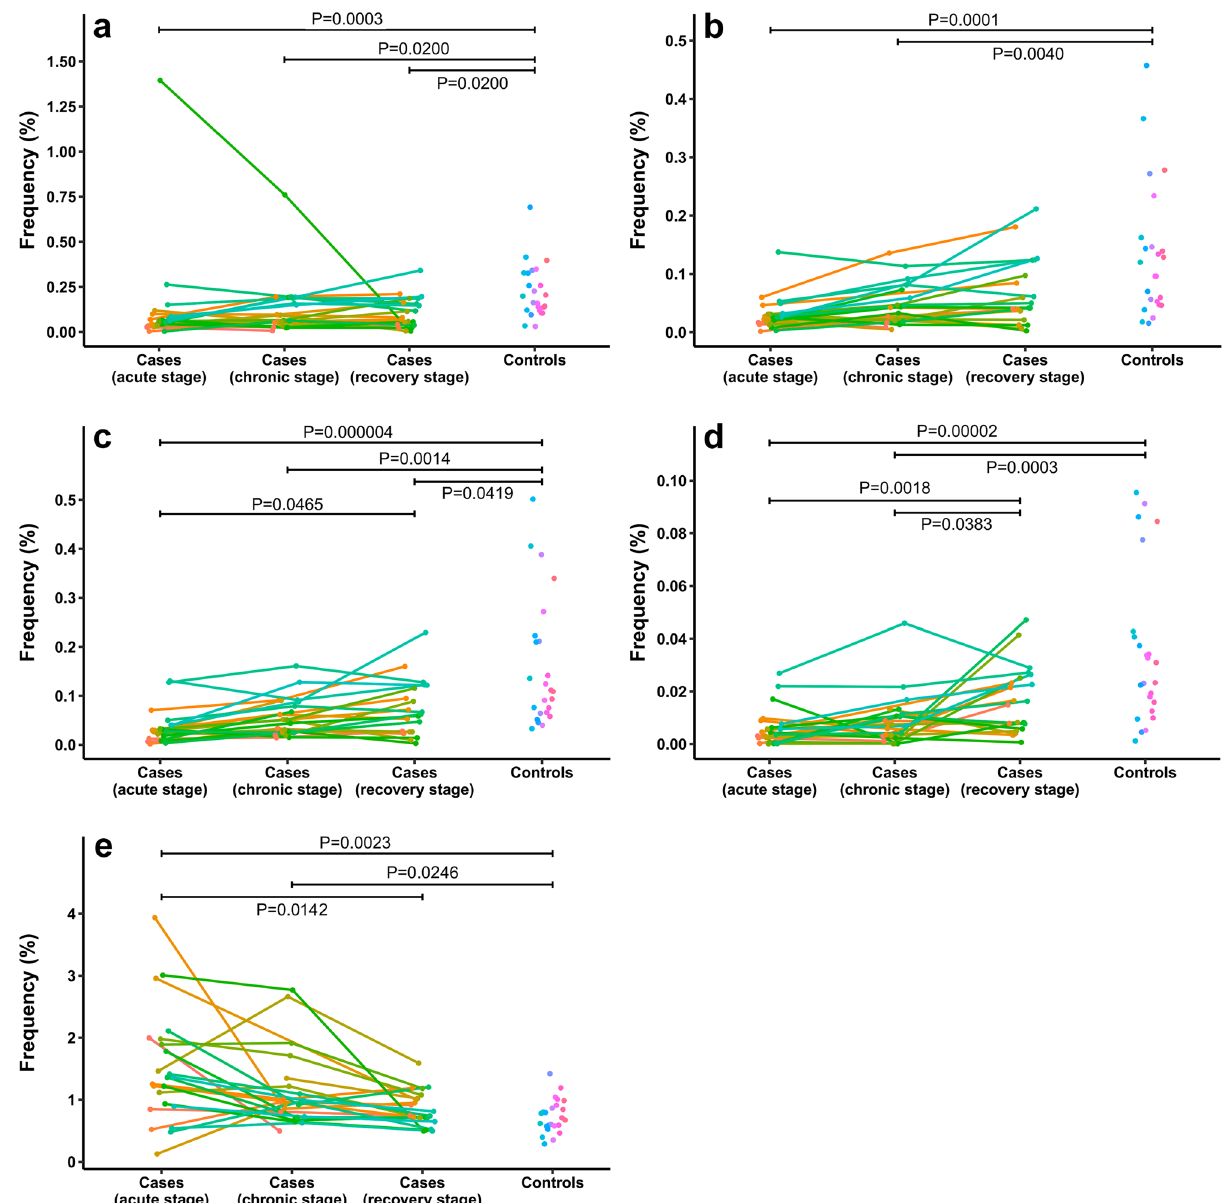
Figure 2. TRBV-TRBJ combination frequencies of the OMDT cases in acute, chronic, and recovery stages and of the controls. ( a ) TRBV6-4-TRBJ2-1. ( b ) TRBV6-4-TRBJ2-2. ( c ) TRBV6-4-TRBJ2-3. ( d ) TRBV6-4-TRBJ2-6. ( e ) TRBV7-9-TRBJ2-1. Dots of the same color represent TRBV-TRBJ combination frequencies of the same subject, the connecting lines indicate varying trends, and P values were obtained by the Man-Whitney U test with Holm’s